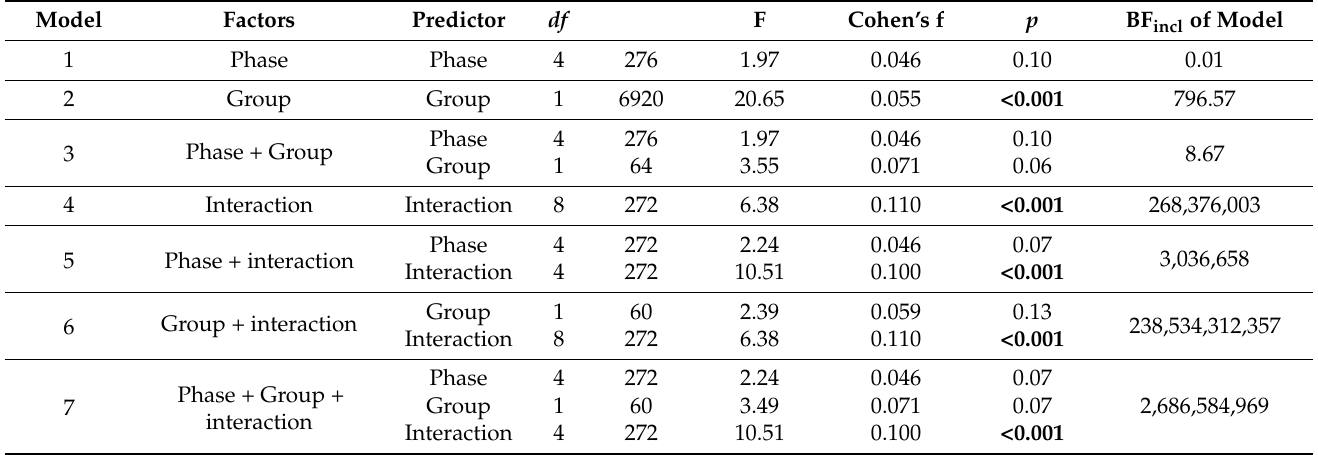
Table 2. Statistical results from frequentist and Bayesian ANOVA for the proportion correct.